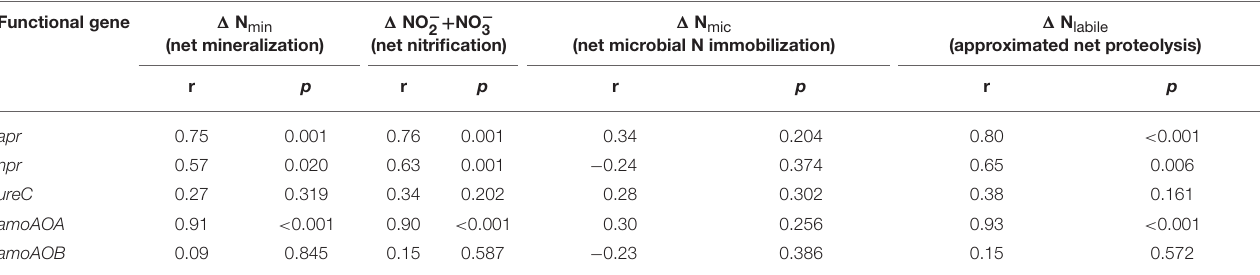
TABLE 2 | Overview of relationship between functional genes and associated biochemical fluxes. Functional